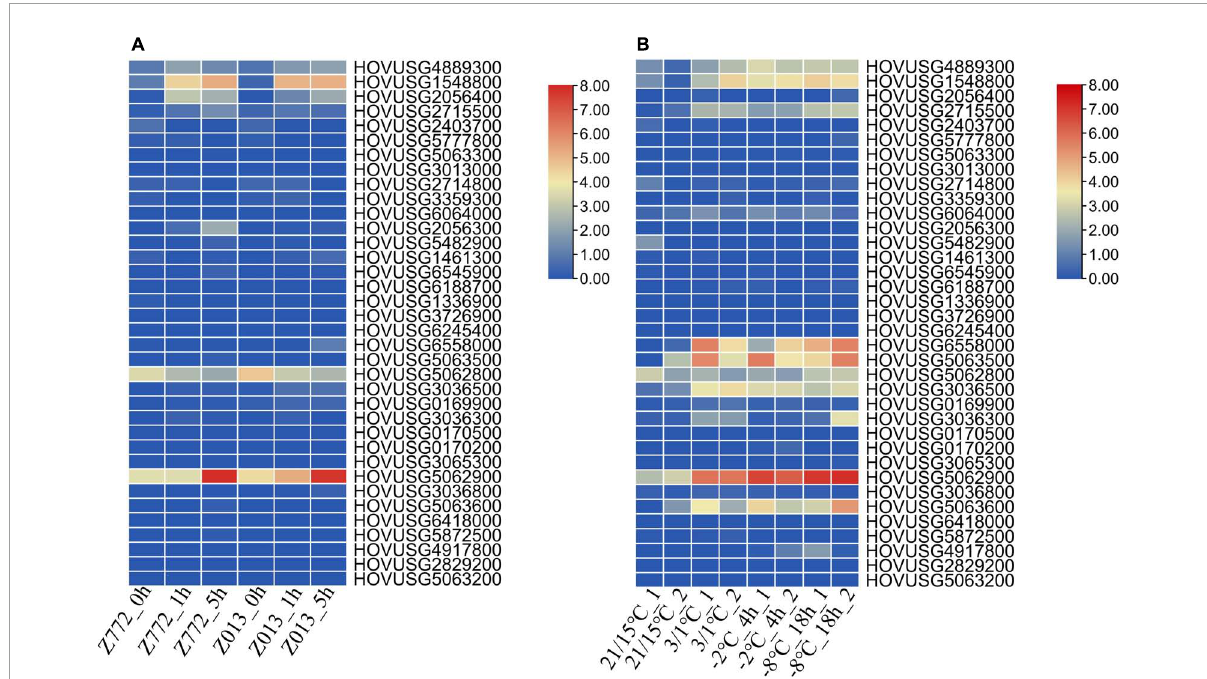
FIGURE7 Expression of Qingke TLP genes in response to drought and cold stresses. (A) Expression of Qingke TLP genes in drought-tolerant cultivar Z772 and drought-sensitive cultivar Z013 at 0, 1, and 5 h post-stress treatment. (B) Expression of Qingke TLP genes in the cold-tolerant cultivar Tibet148 subjected to 20/15 ◦ C (day/night), 3/1 ◦ C (day/night), –2 ◦ C (for 4 h) and –8 ◦ C (for 18 h) stress treatments. The RNA-seq data was downloaded from SRA database, and aligned to the Qingke genome to calculate the expression levels of TLP genes. Bars are colored according to the log2 (TPM + 1) values.